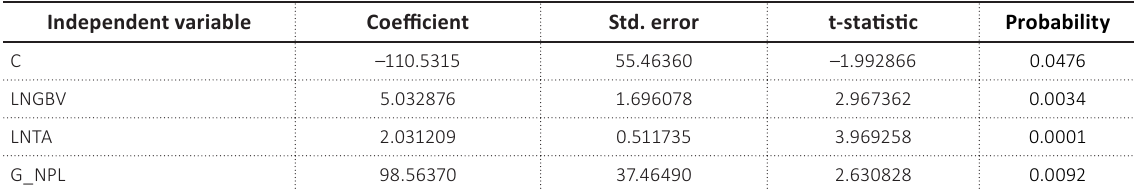
Source: Modified Output of E-Views